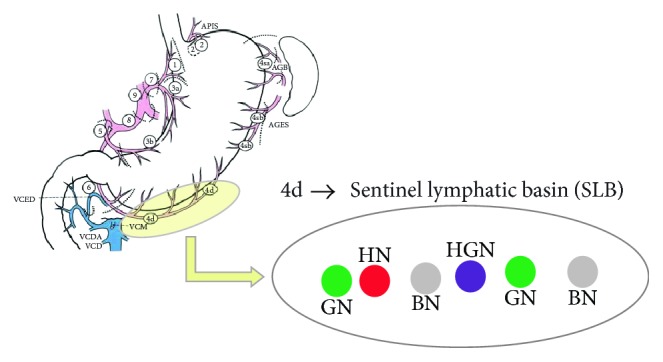
Definition of sentinel basin nodes. GN: green node, HN: hot node, HGN: hot and green node, and BN: basin node.